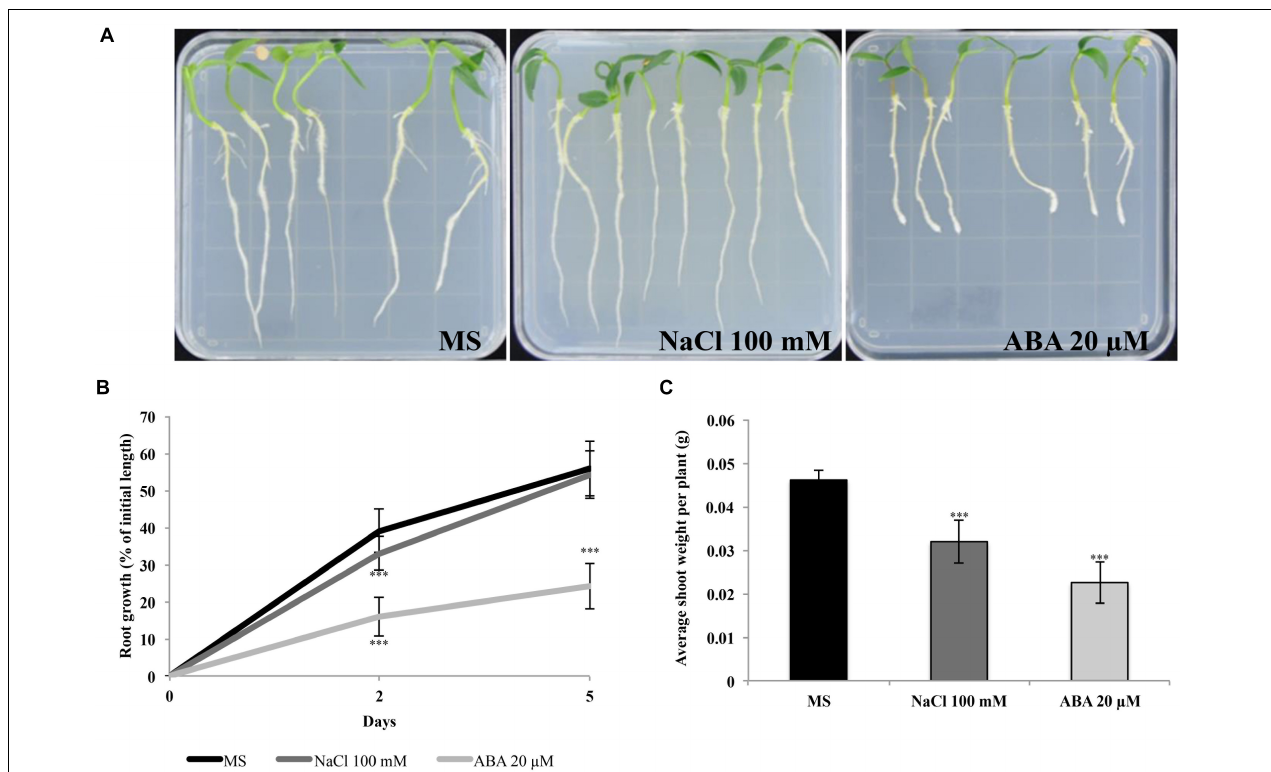
FIGURE 2 | QA seedling sensitivity to ABA and NaCl. (A) Representative plates of seedlings grown on control, NaCl and ABA media. (B) QA seedling root growth measured as percentage of initial length. (C) Shoot weight (normalized per plant). Seedlings were transferred from germination media after 9 days and were grown on vertical plates for 5 days in the presence of 100 mM NaCl or 20 µ M ABA. Values indicate mean ± SD ( n = 24). Asterisks represent significance levels using Student t -test; ∗∗∗ P ≤ 0.005. QA, Quadrato D’Asti